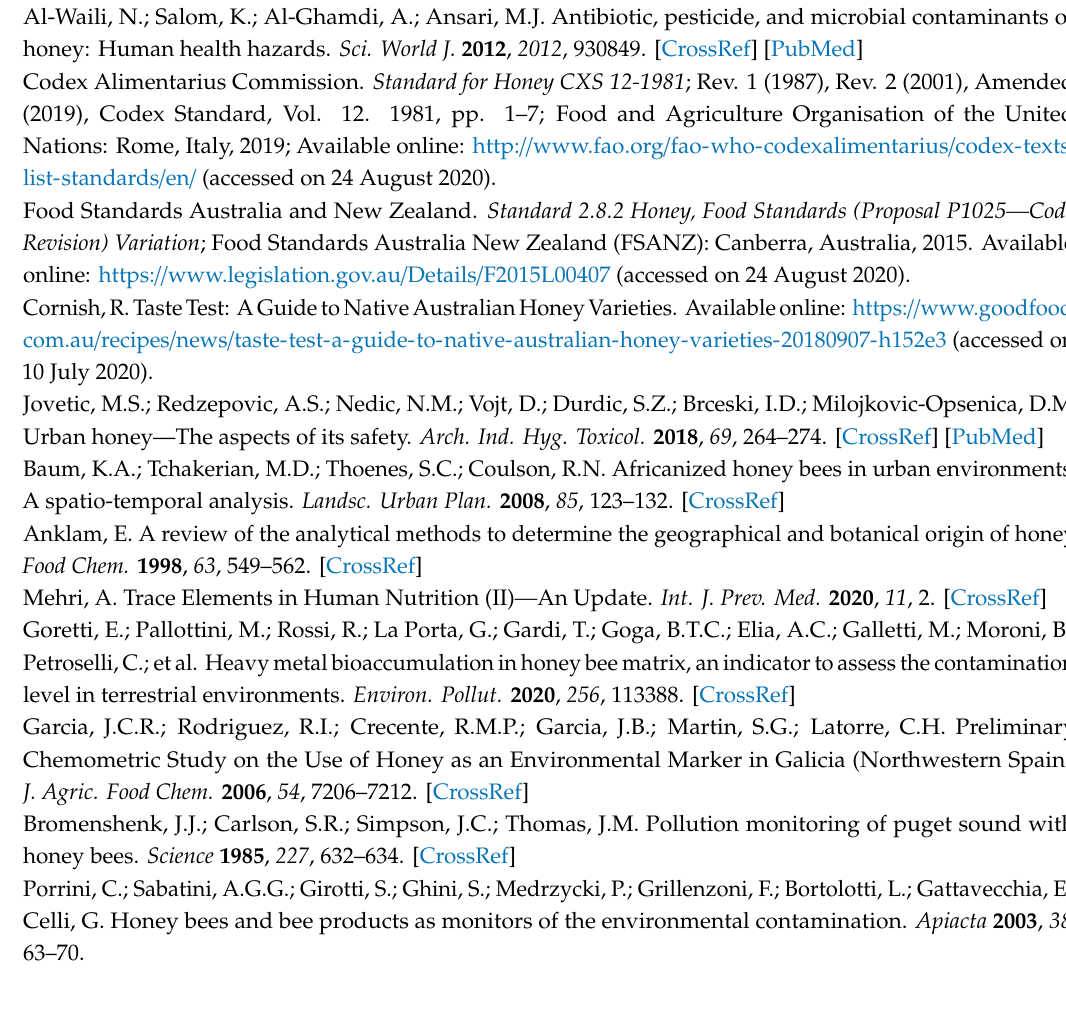
Table S1: Recoveries of elements from standard reference materials, Part A . Elemental analysis by ICP-MS, Part B . Elemental analysis by ICP-OES, Table S2: Spearman correlation coe ffi cients ( r s ) between the concentrations of elements in honey samples, Table S3: Concentration of 26 elements in honey, by